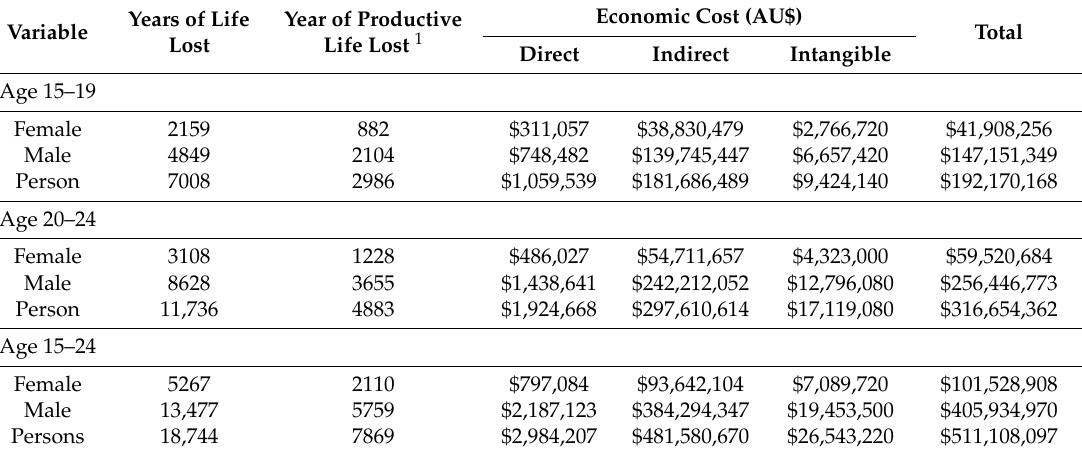
Table 4. The total economic cost of youth suicide, Australia, 2014, by age and